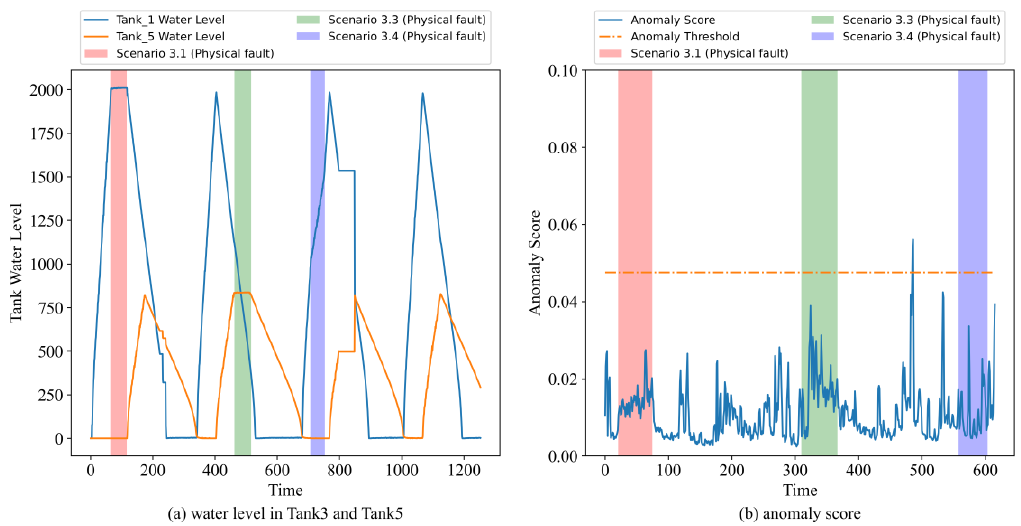
Figure 8. Scenario 1.6. ( a ) Water level in Tank 3; ( b ) anomaly score.